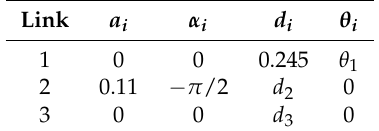
Table 2. DH Parameters of an RPP